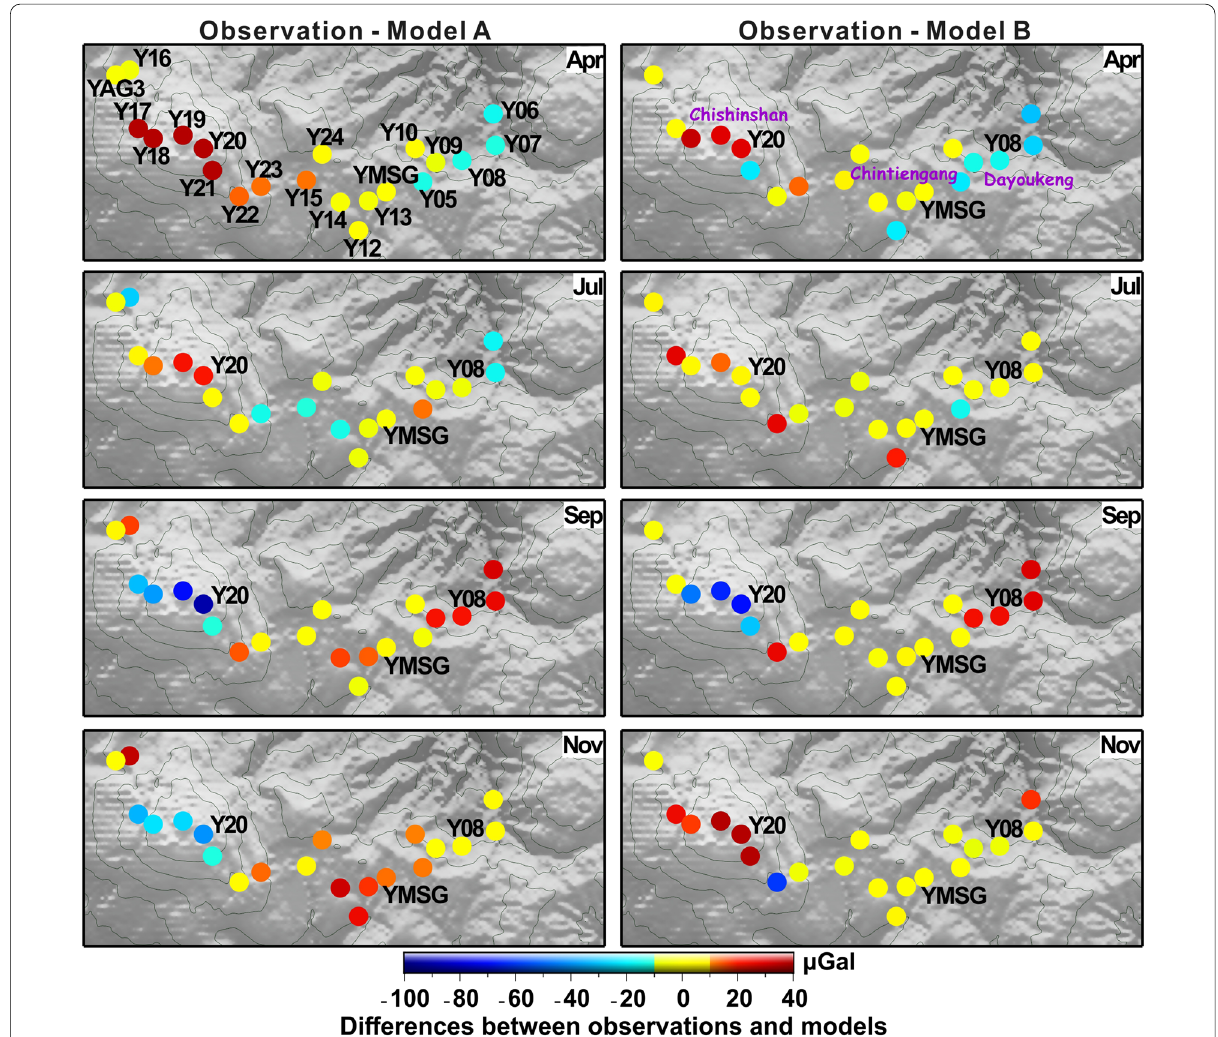
Fig. 9 Differences between the observed and simulated gravity changes. The left column is for Model A, and the right column is for Model B. Positive and negative differences are shown in red and blue circles, respectively. Yellow circles correspond to the sites where the gravity differences are small. Model B results in a better fit with the gravity observations than Model A over the TVG